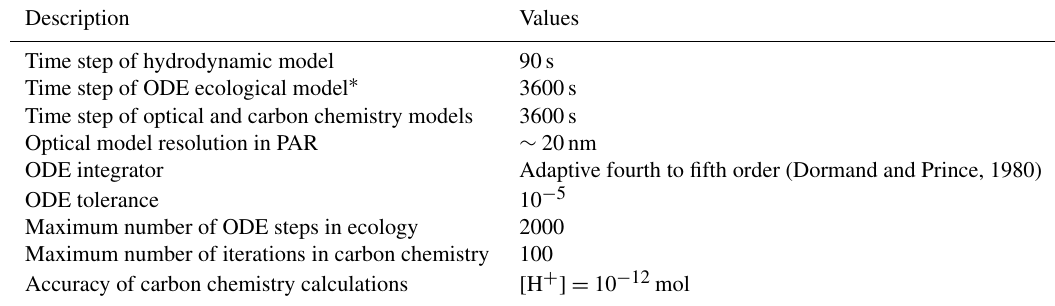
Table 40. Integration details. Optical wavelengths are 290, 310, 330, 350, 370, 390, 410, 430, 440, 450, 470, 490, 510, 530, 550, 570, 590, 610, 630, 650, 670, 690, 710 and 800nm.